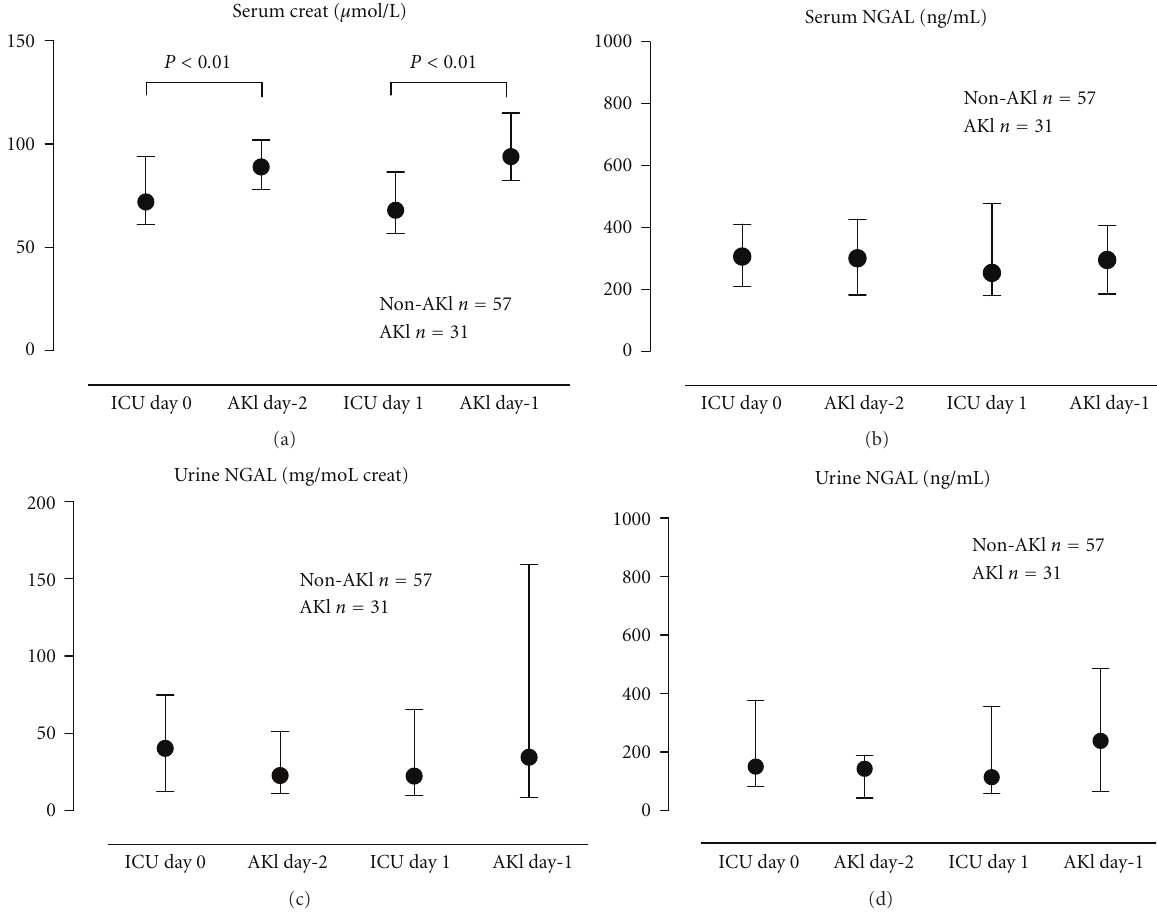
Figure 2: Neutrophil gelatinase-associated lipocalin (NGAL) in serum and urine and creatinine 1 and 2 days prior to acute kidney injury (AKI). Levels are compared to day 0 and day 1 in patients who never developed AKI. Non-AKI patients, N = 57; AKI patients, N = 31.